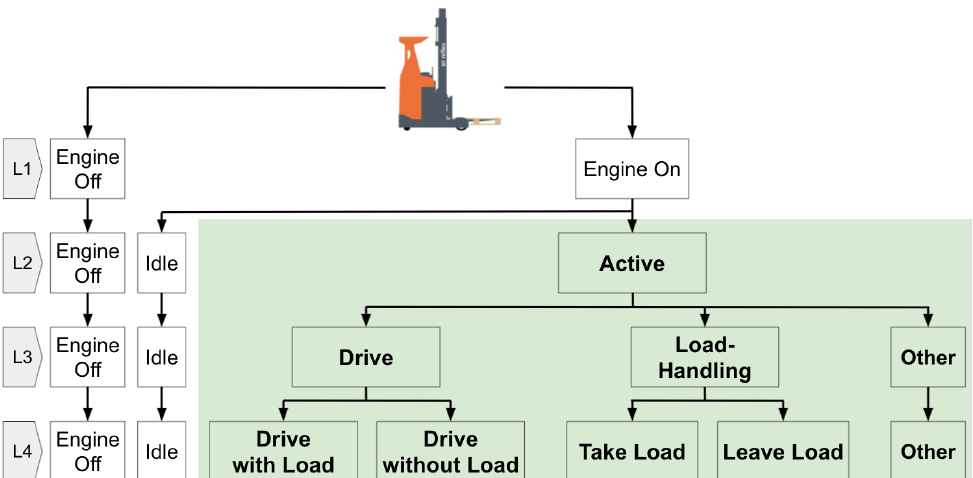
Figure 1. LoD of Forklift Truck Activities.